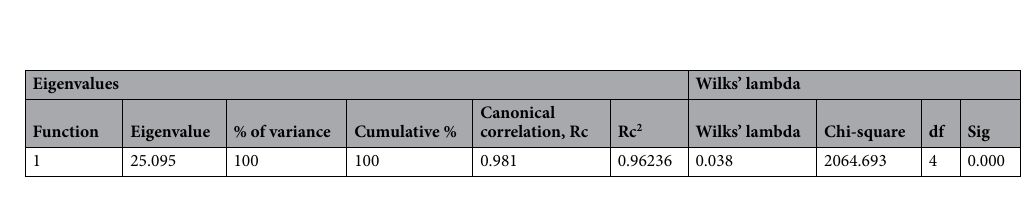
Table 9. Eigenvalues, canonical correlation and Wilk’s lambda test of discriminant function based on urothelial and prostate lineage gene expressions.